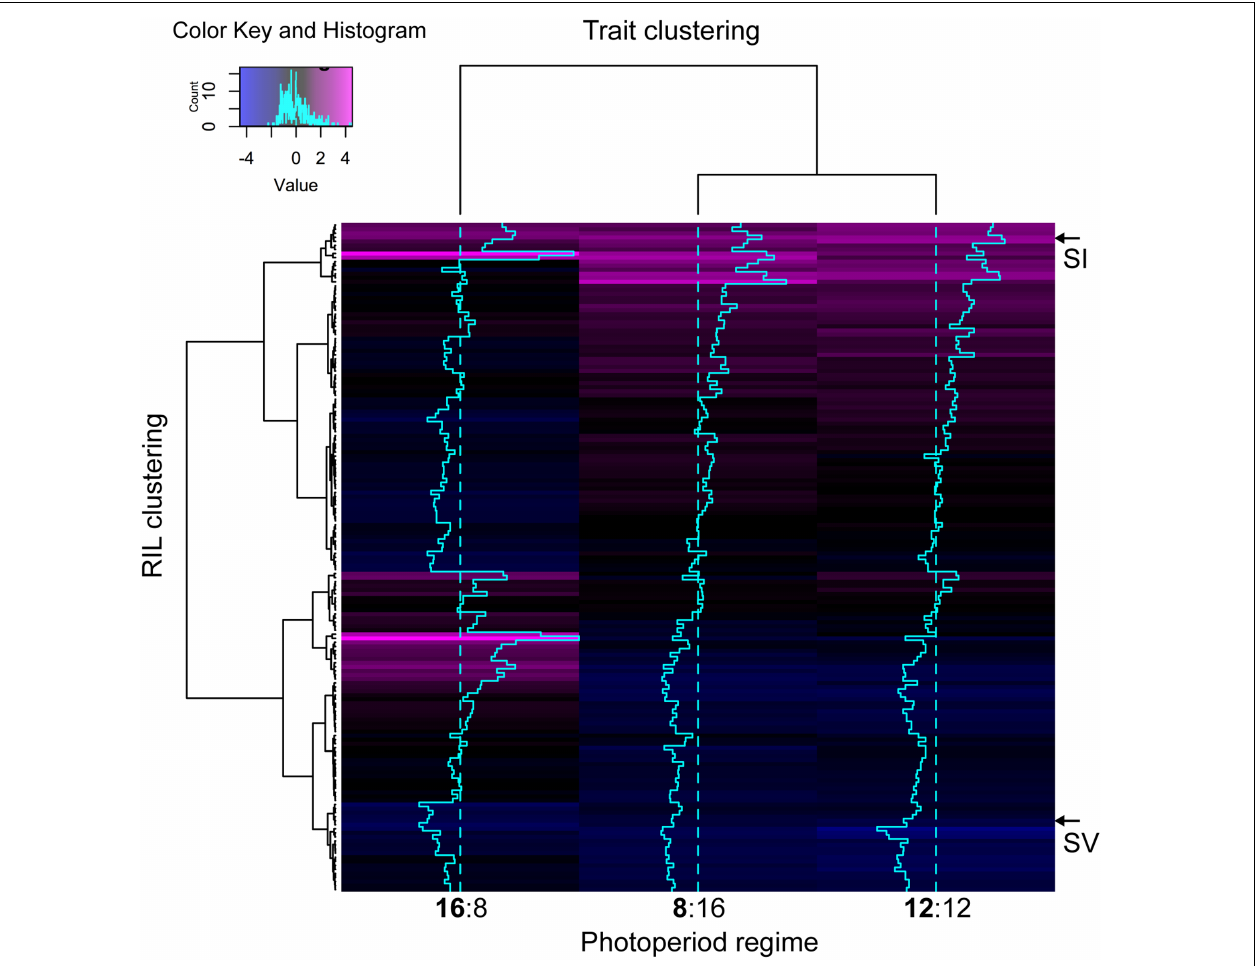
FIGURE 2 | Heatmap visualizing the underlying structure of heading date phenotypes both between individual accessions (rows), and treatment groups (columns). Trace-lines down each treatment group (turquoise) show the degree to which each accession deviates from the mean (dashed line). The A10 S. viridis and B100 S. italica parents are indicated as ‘SV’ and ‘SI’ respectively. Black or blue coloration indicates that the RIL is early flowering with respect to the rest of the population in that trial, whereas magenta indicates relatively late flowering.